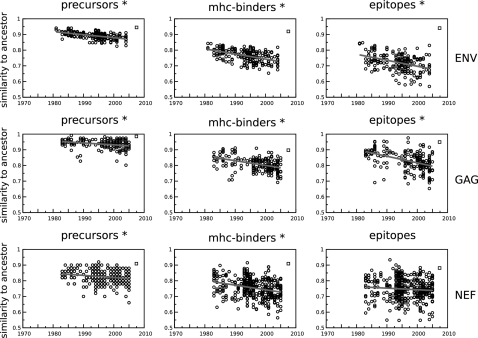
The predicted fraction of ancestral epitope precursors, MHC-binding peptides and CTL epitopes present in the HIV-1 clade B sequences declines over time.The predicted fraction is plotted per sequence as a dot on the y-axis. Ancestral epitope precursors are defined by their C-terminal position (Fig. 1, 10th amino acid from the left) in the aligned sequences [3]. Similarly, MHC-binding peptides and CTL epitopes are defined by their C-terminal, but also by the MHC that they are predicted to bind to. *: significant decrease over time (Kendall Tau rank correlation test, p<0.01). The consensus sequence [65] is plotted as a square on the right-hand side of each panel.